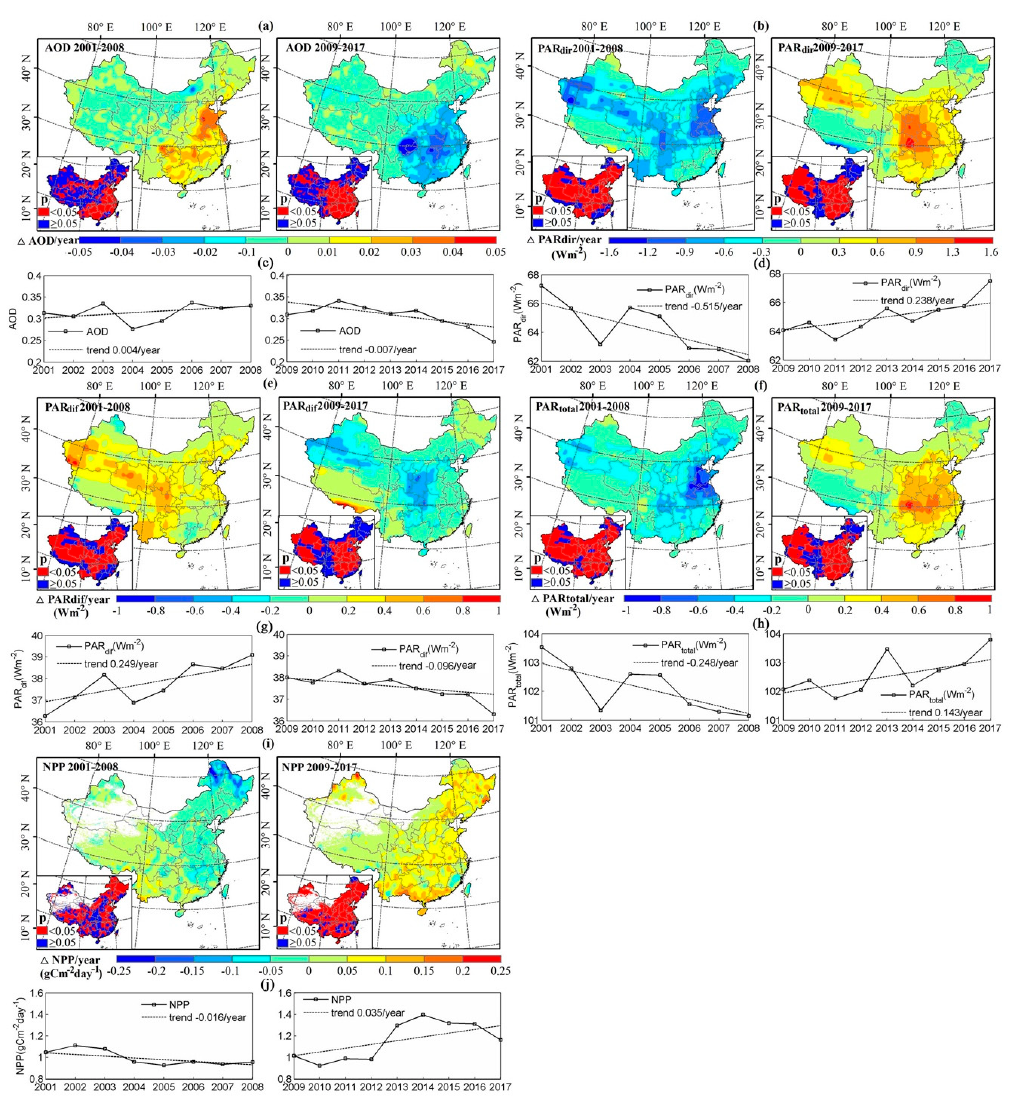
Figure 5. Spatial variation of trends for AOD ( a ), PAR dir ( b ), PAR dif ( e ), PAR total ( f ) and NPP ( i ) during 2001–2008 and 2009–2017. Red area indicates trends with p-value < 0.05 and blue area indicates trends with p-value ≥ 0.05. The temporal variation of annual mean values over China are ( c , d , g , h , j